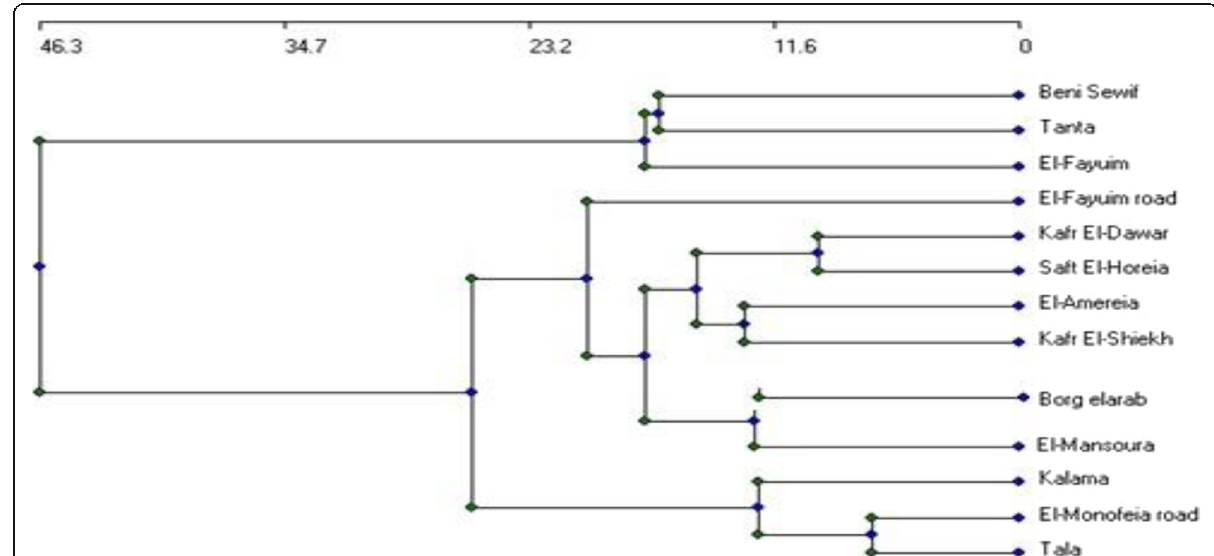
Fig. 3 UPGMA dendrogram based on data generated from biochemical and molecular markers, showing the genetic linkage distance among the studied samples of Silybum marianum